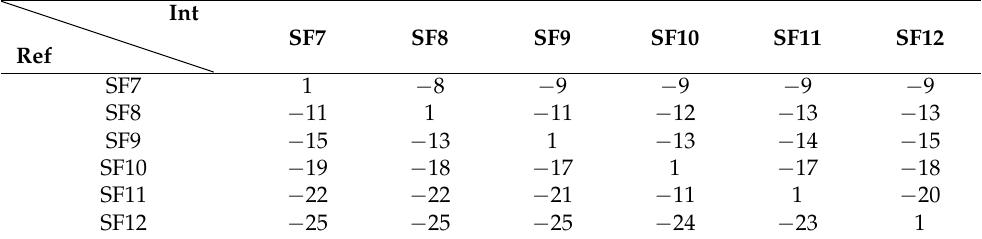
Table 6. SIR Thresholds [dB] [8].